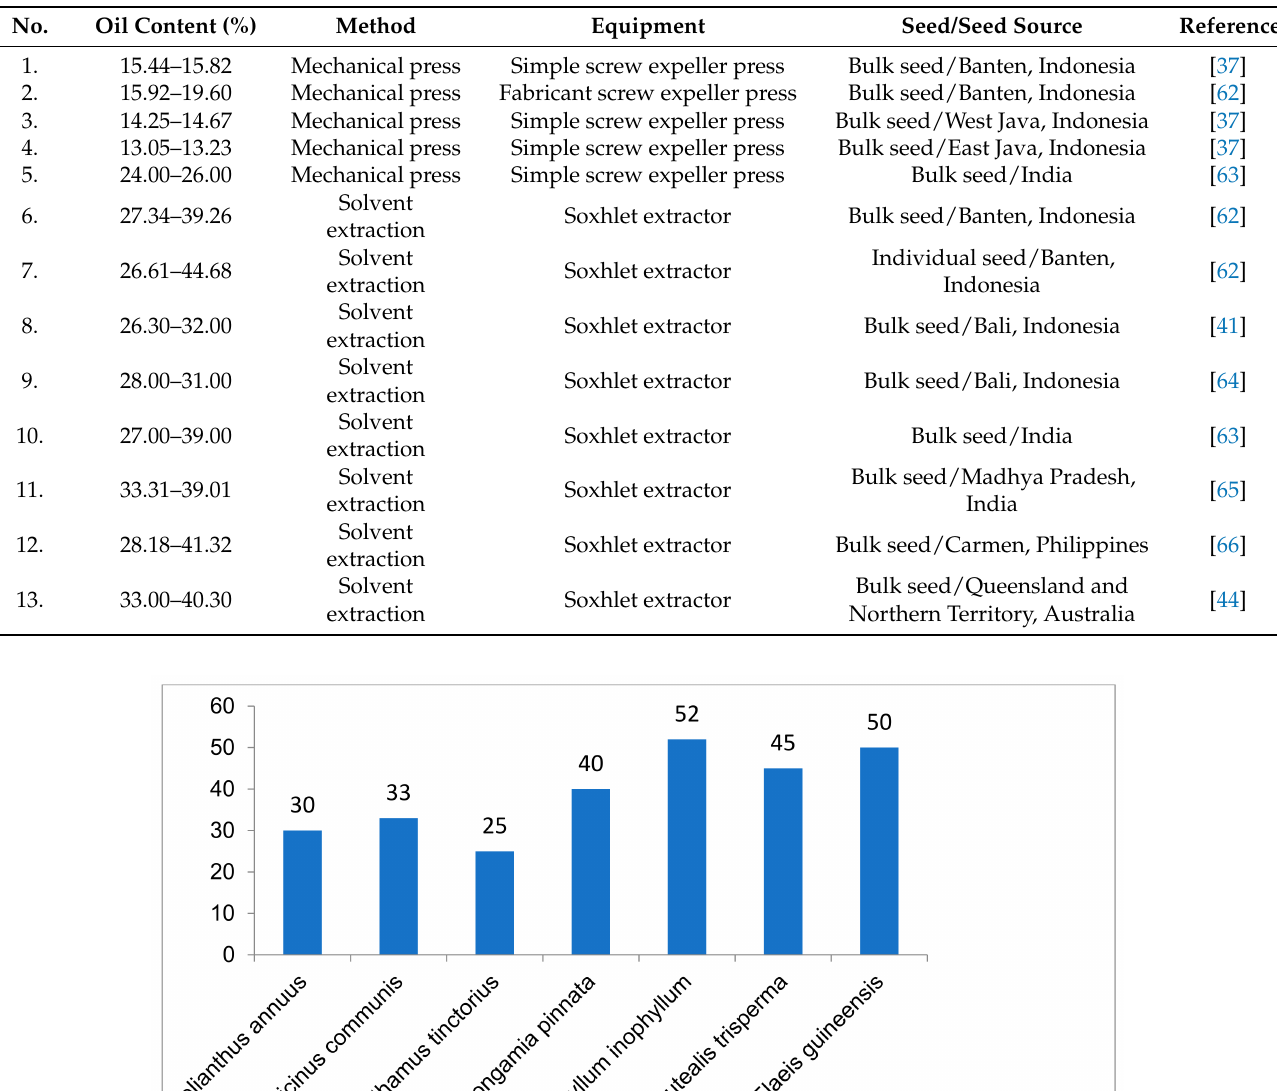
Table 5. Pongamia oil content from different seed sources and extraction methods.